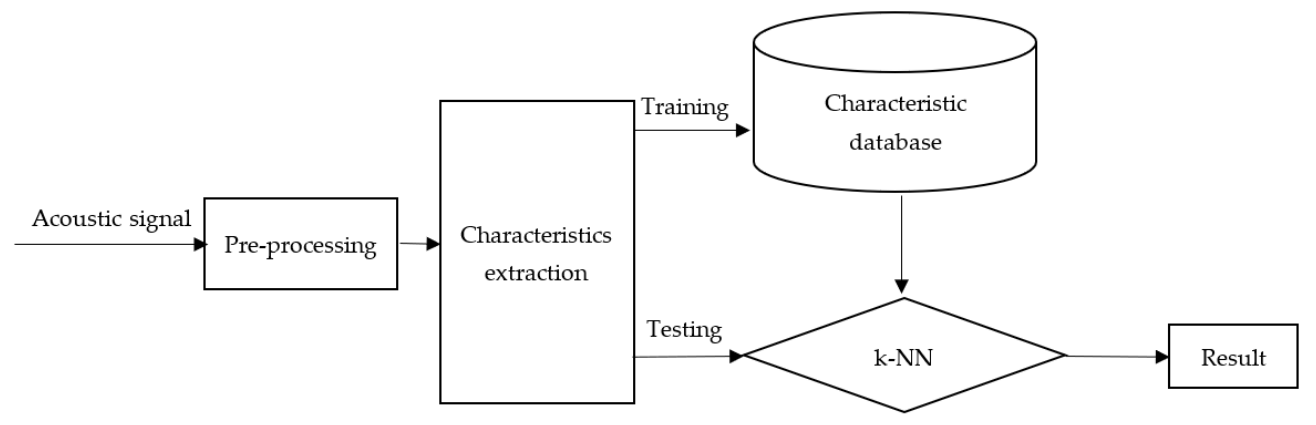
Figure 3. Block diagram of the acoustic signal processing system.